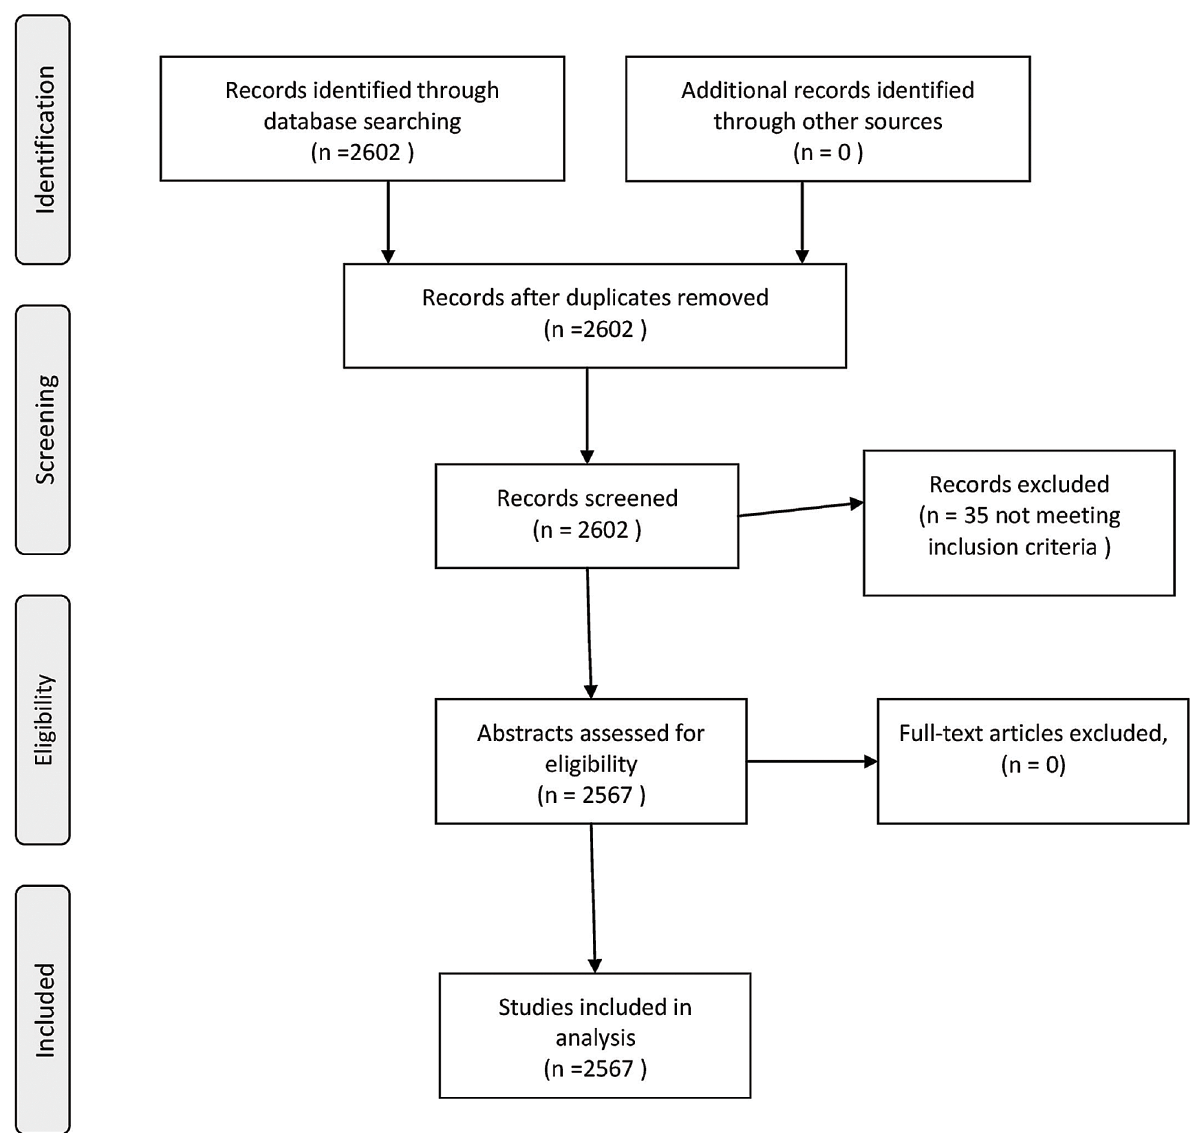
Figure 1. Flow chart.